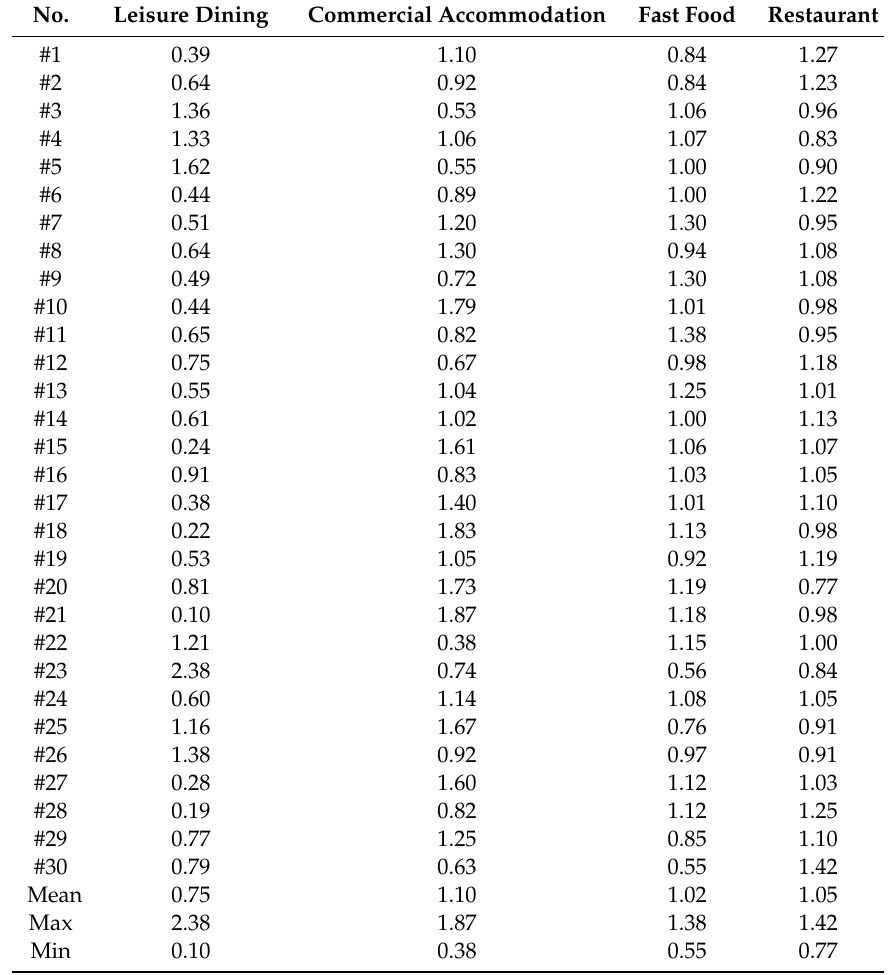
Table A1. Location quotients of Beijing’s accommodation and catering industry cluster